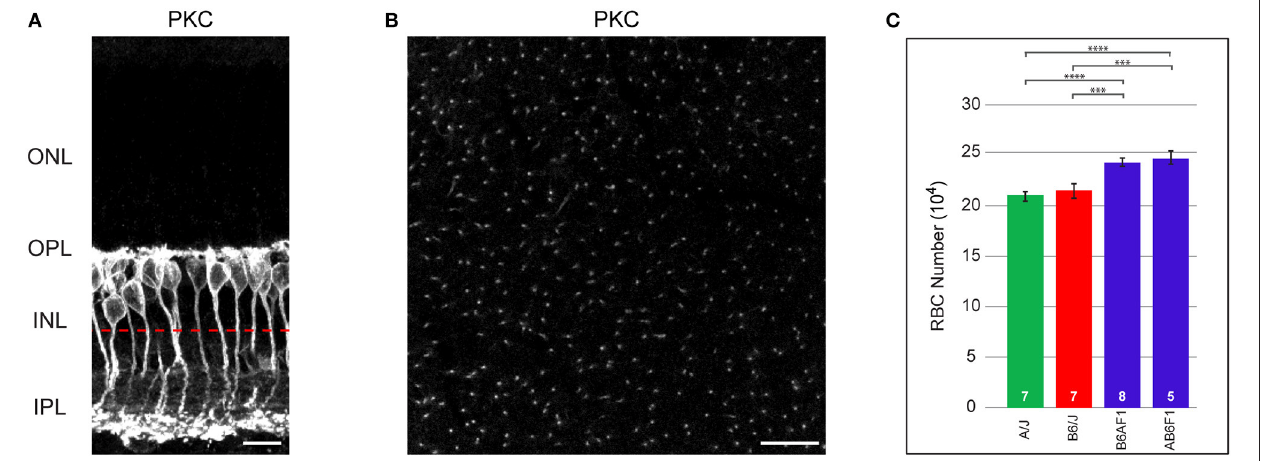
FIGURE 1 | (A) RBCs, labeled with antibodies to PKC, are closely packed at the outer margin of the INL. RBC axons course through the INL to reach the IPL, where they terminate in the inner-most ON stratum. (B) When imaged in wholemount preparations, individual axons are reliably discriminated. The approximate focal plane in (B) is indicated by the dashed red line in (A) . (C) Total number of RBCs in the parental B6/J and A/J strains, and in their reciprocal F1 offspring, B6AF1 and AB6F1. Each parental strain differs significantly from each F1 strain, but the two parental strains and the two F1 strains do not differ significantly from one another. Scale bar: (A) = 10 µ m; (B) = 25 µ m. *** p < 0.001; **** p <